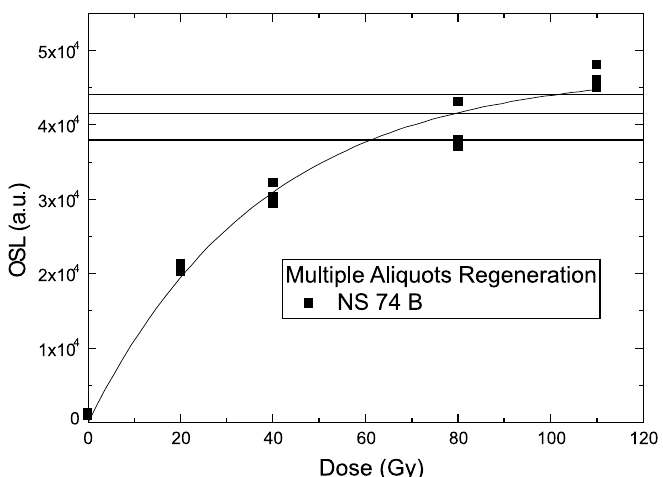
Fig. 2 – OSL calibration curve using the method of multiple aliquots and total re- generation method for the sample NS-74. See figure 1 for the location of the